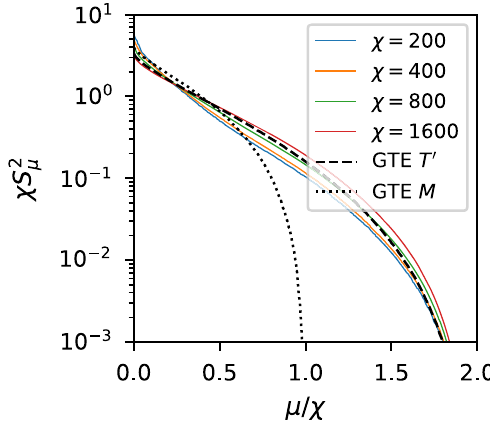
FIG. 10. Squared singular values S 2 μ of the matrix T 0 obtained from the MPS simulations of N ¼ 30 qubits and a depth of D ¼ 60 for various values of χ . The singular values correspond to a gate C performed in the middle of the system. Dotted line: X squared singular values of the M matrix in the GTE. Dashed line: squared singular values of T 0 in the